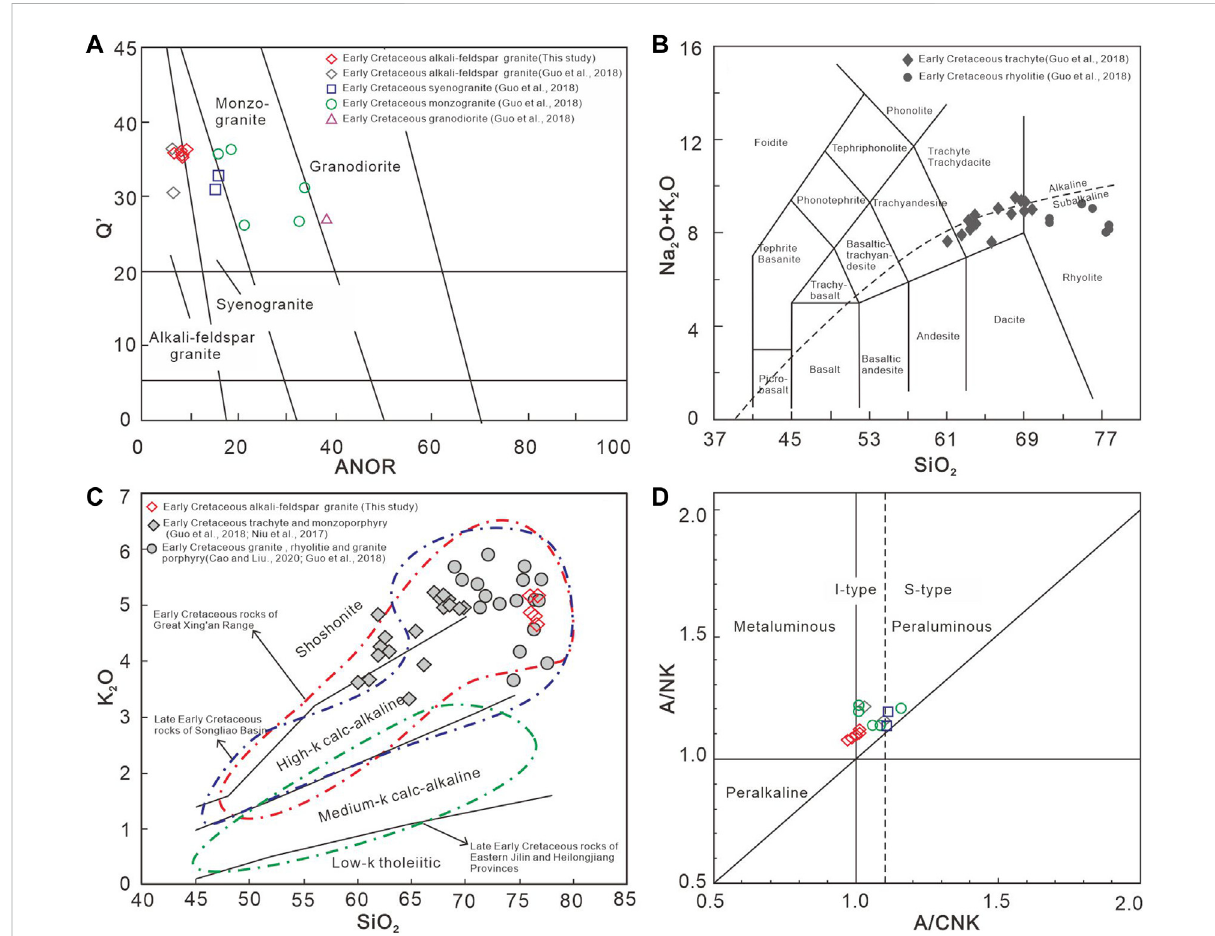
FIGURE 6 Classi fi cation and series diagrams of the alkali-feldspar granite. (A) Q ′ versus ANOR diagram [Q ’ = 100*Q/(Q + Ab + Or + An); ANOR = 100*An/ (An+Or),StreckeisenandLeMaitre,1979]; (B) Totalalkalis versus SiO 2 diagram(LeMaitre,2002); (C) K 2 O versus SiO 2 diagram(PeccerilloandTaylor, 1976), The data of dotted line area are from Guo et al. (2018); (D) A/NK versus A/CNK diagram (A/NK = Al 2 O 3 /(Na 2 O+ K 2 O), A/CNK= [Al 2 O 3 /(CaO + Na 2 O+ K 2 O; Maniar and Piccoli,